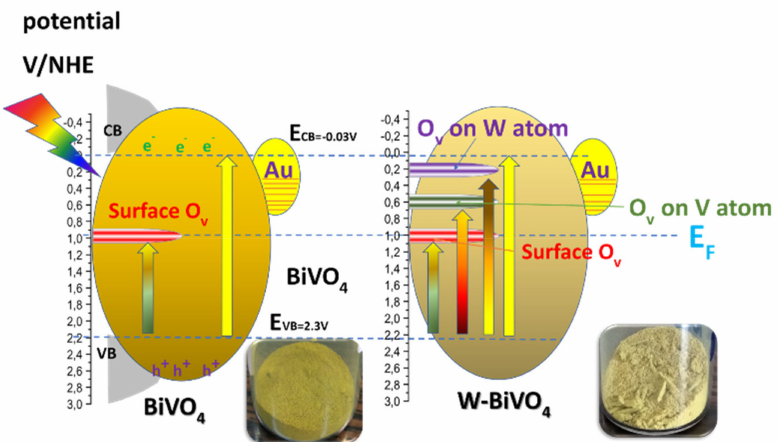
Figure 5. Schematic depiction of the energy levels of FSP-made photocatalysts. Surface O-vacancies create Fermi-level states in BiVO 4 ( left ). In addition, W-doping ( right ) generates additional intraband states whose position depends on the relative location of W, V atoms and O-vacancies